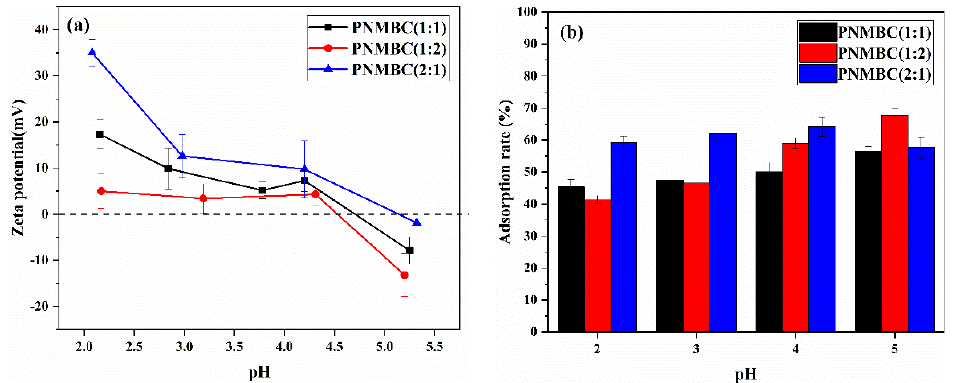
Figure 7. ( a ) Zeta potential of PNMBC biosorbent and ( b ) the adsorption efficiencies at different pH levels.